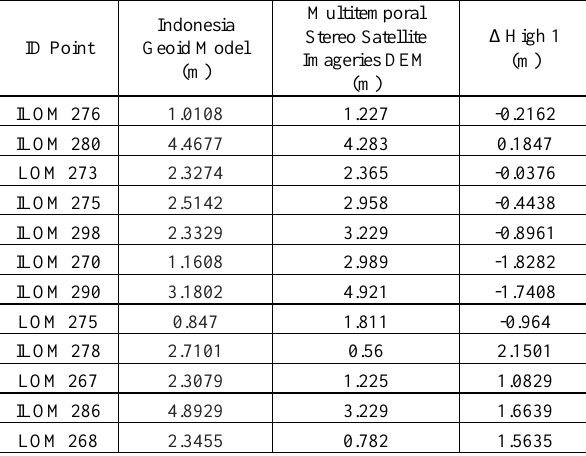
Table 2. Differences high value between Multitemporal Stereo Satellite Imageries and Indonesia geoid model